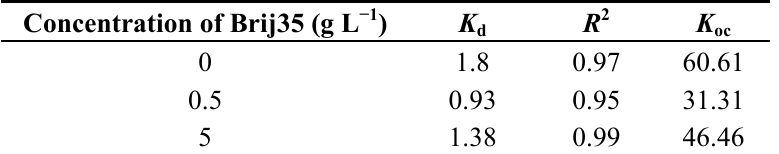
Table 2. Distribution coefficient K presence of the nonionic surfactant